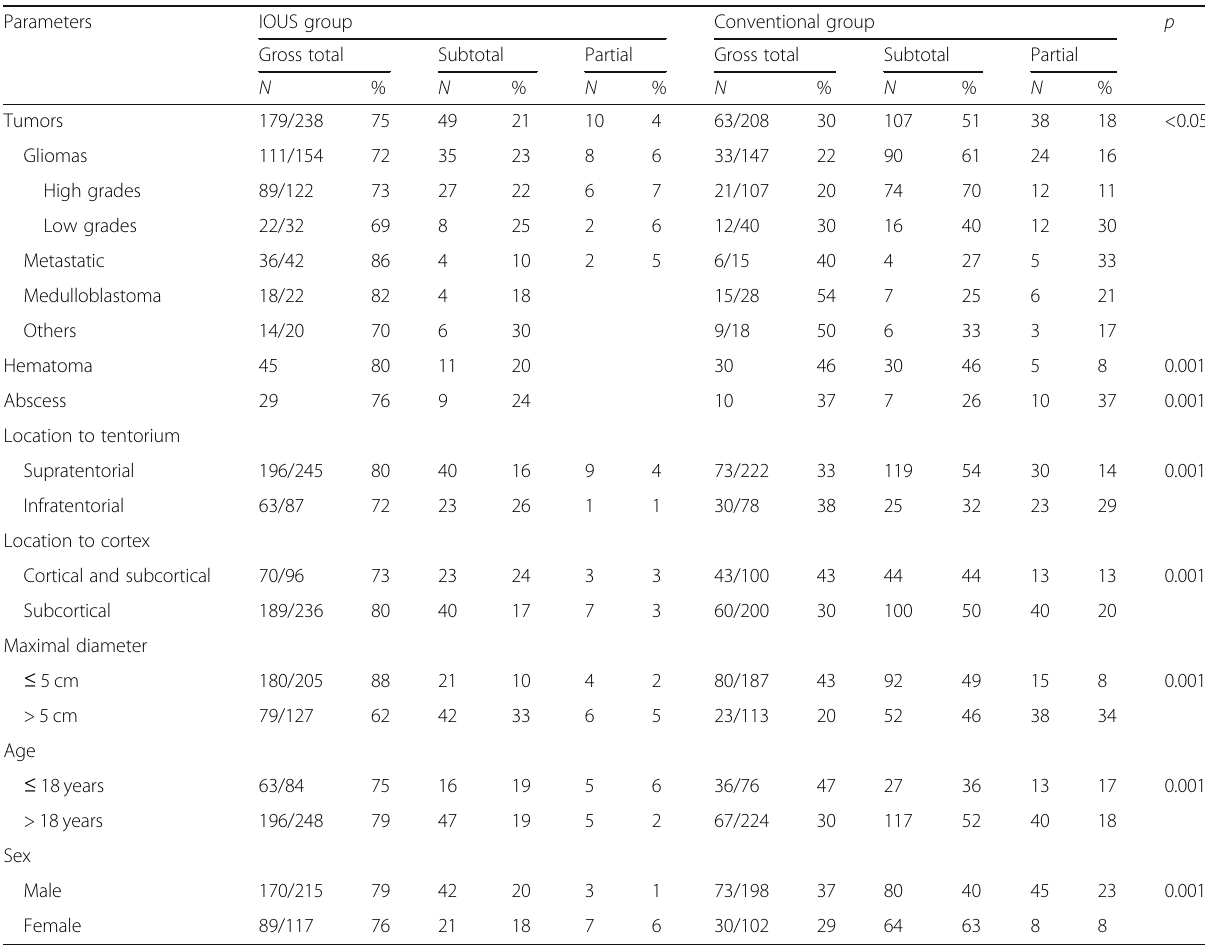
Table 2 Extent of mass lesion resection comparison between both groups Parameters